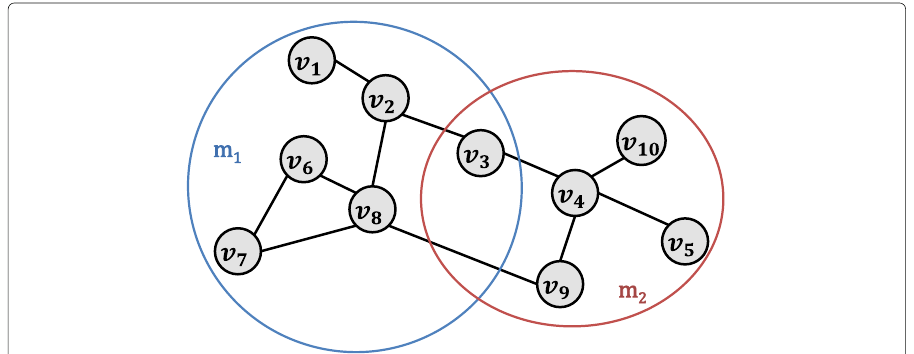
Fig. 1 A network with 10 nodes and 11 links. The measurements m 1 and m 2 are feasible considering the network topological constraints (each of them induces a connected sub-graph over the